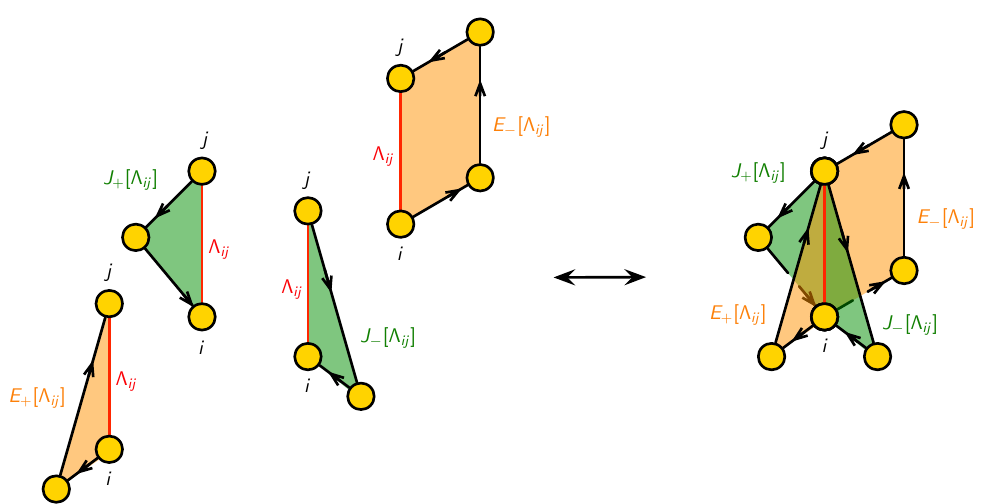
Figure 5 . The four plaquettes associated to J ± [Λ ij ] and E ± [Λ ij ] for a Fermi field Λ ij in the periodic quiver dual to a brane brick